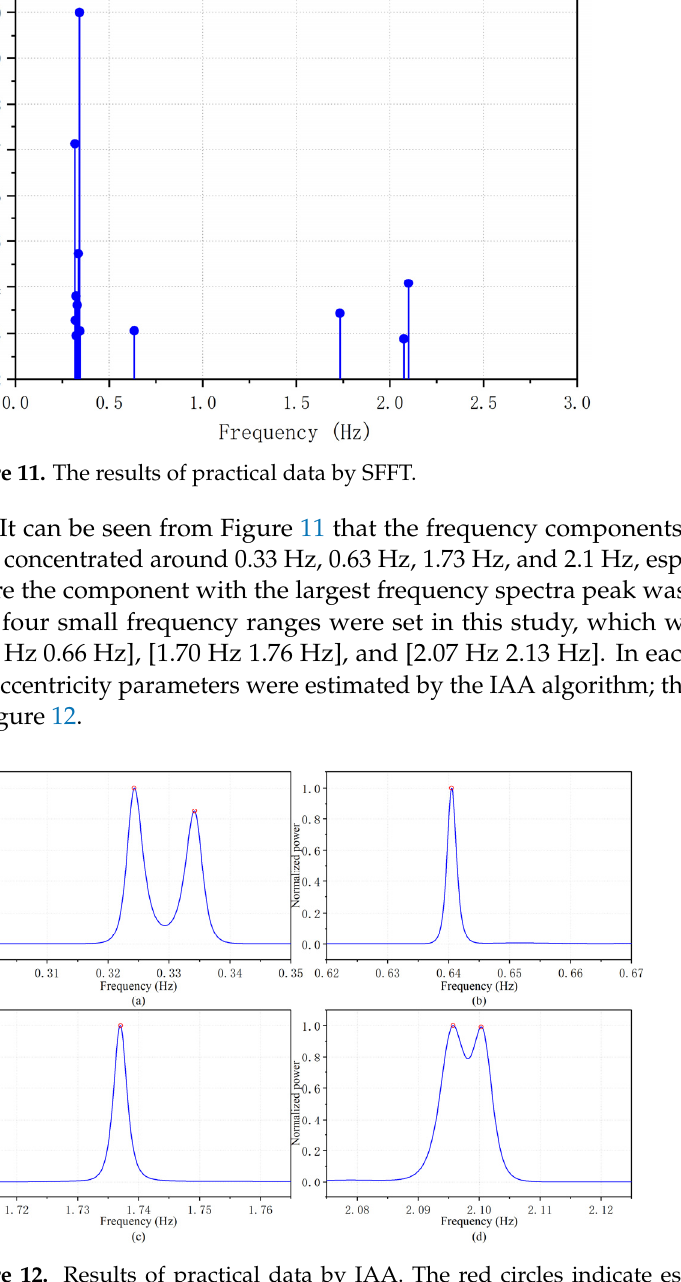
Figure 10. Curve of practical rolling data. ( a ) Rolling force; ( b ) roll gap.